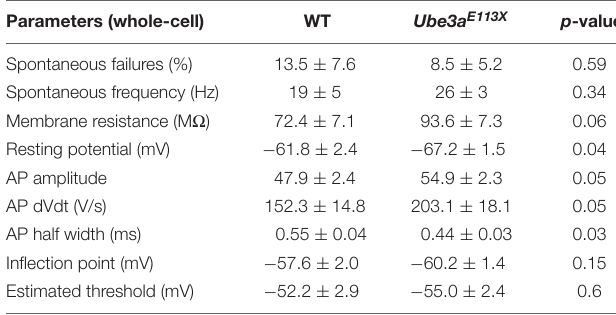
TABLE 2 | Comparison of spontaneous firing, complex waveforms and intrinsic properties between WT and Ube3a 113X